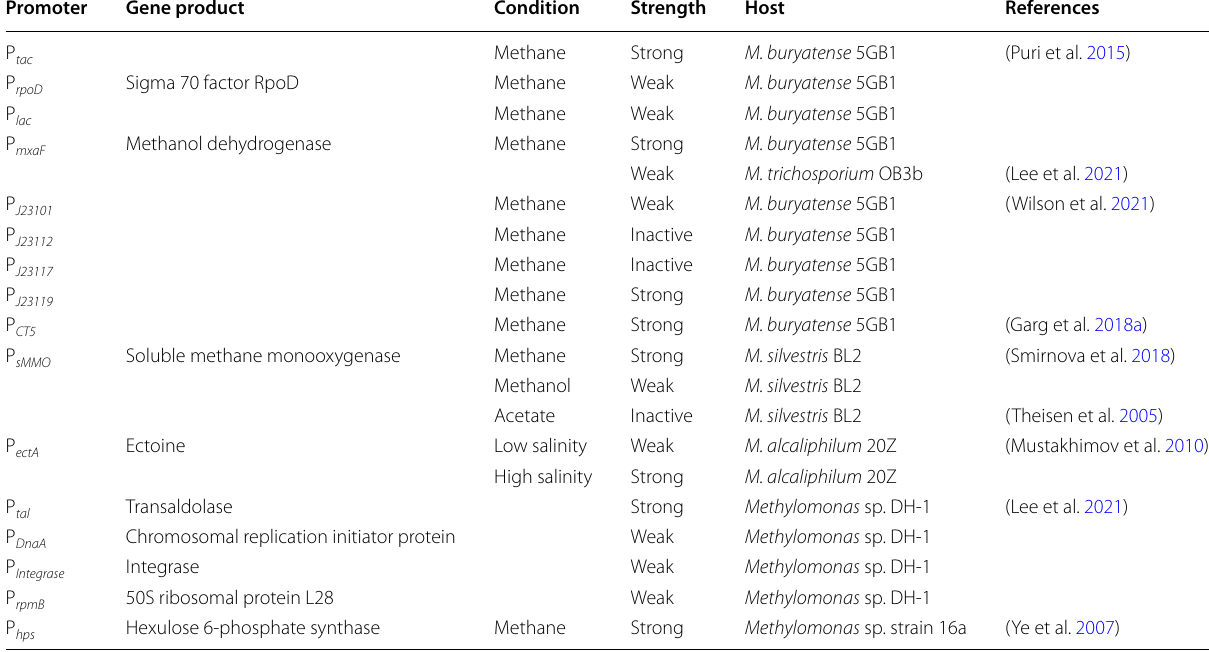
Table 1 The intensity of different reported promoters in Methylotrophic bacteria Promoter Gene